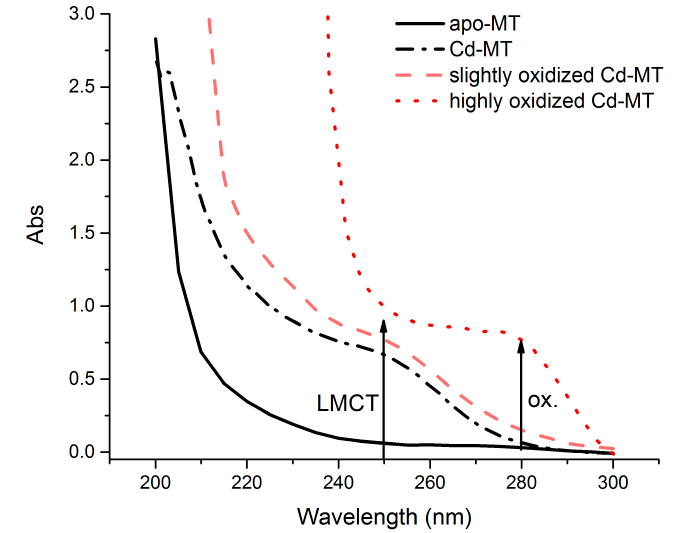
Figure 1. Far UV absorption spectra of metallothionein (MT) used to monitor oxidation of thiols. Apo-MT (solid black line), Cd-MT (dashed black line) are both fully reduced with no thiol oxidation. Aerated MT solutions are shown to illustrate the oxidation: minimal oxidation (dashed pink line) and significant oxidation (dotted red line). The ligand-to-metal charge transfer (LMCT) band and the oxidized thiol absorbance are highlighted with arrows.